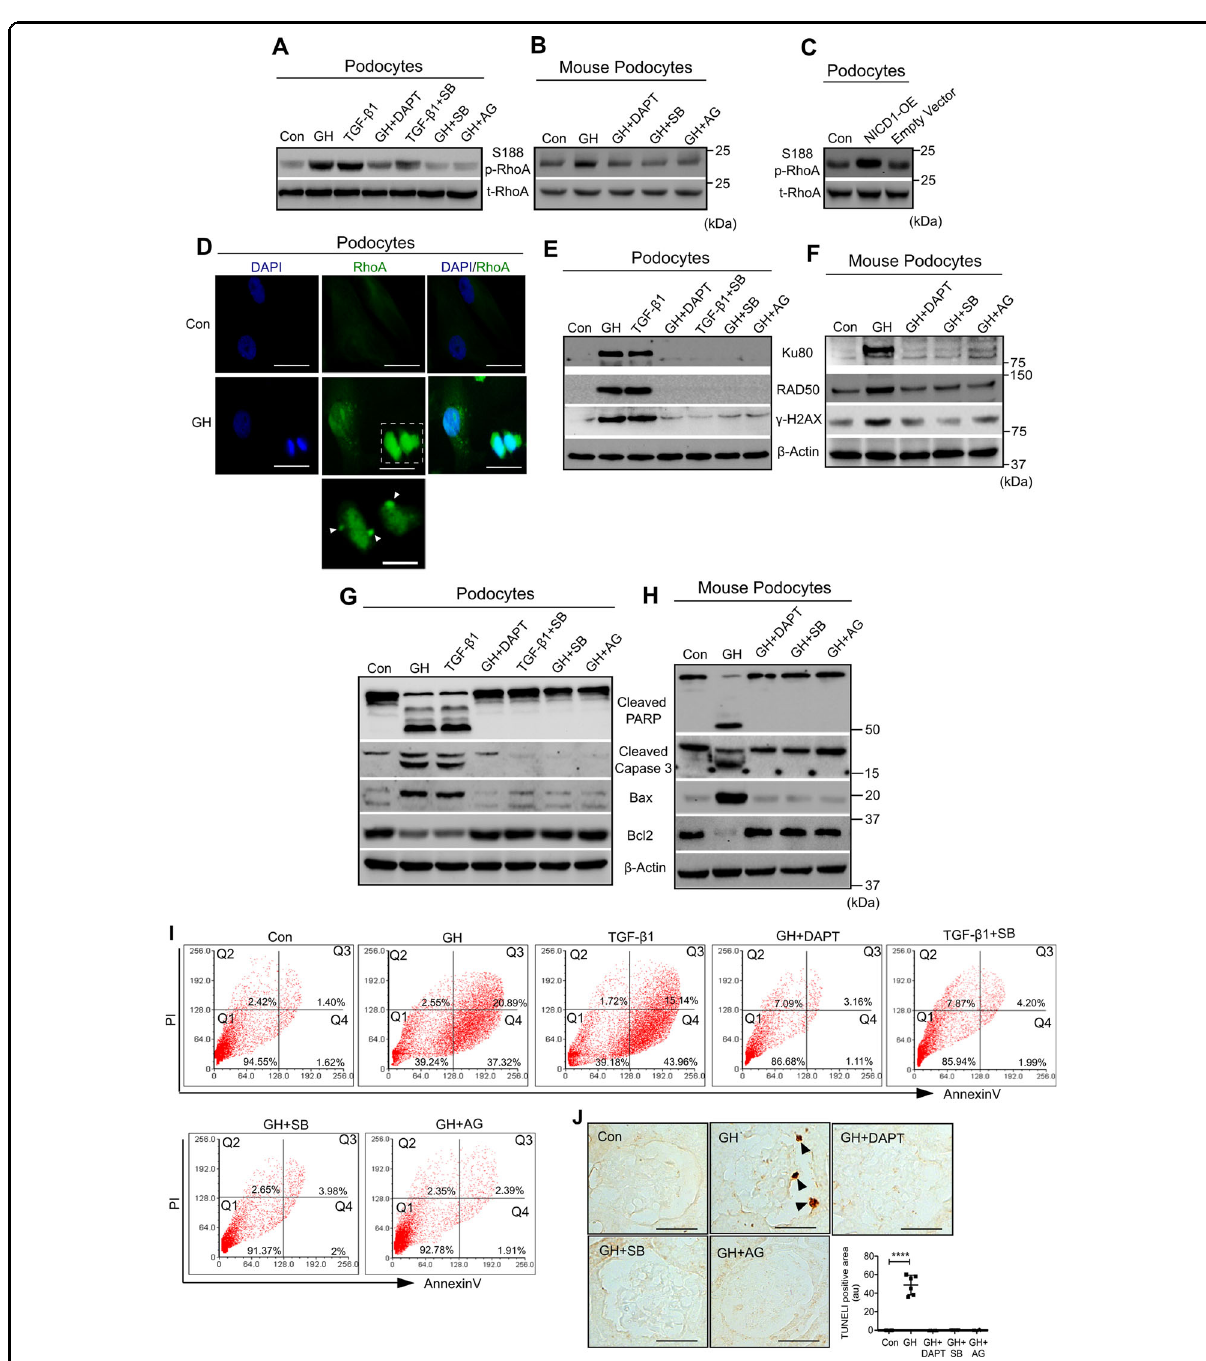
Fig. 4 GH-induced TGF- β leads to podocyte DNA damage and apoptosis. A , B Immunoblotting analysis in human podocytes (treated for 48 h) and from mouse podocytes ( n = 3). C Immunoblotting analysis in human podocytes ectopically expressing NICD1 (NICD1-OE). ( n = 3). D Immuno fl uorescence for the RhoA (green color) and counterstained with DAPI (blue color) in human podocytes treated with GH for 48 h. Magni fi cation ×630. Scale bar = 20 μ m. ( n = 3). White arrowhead indicates the delocalization of RhoA from midbody. E – H Immunoblotting analysis in human podocytes ( E , G ) and mouse podocytes ( F , H ). ( n = 3). I Human podocytes stained with FITC-Annexin V and PI and analyzed by fl ow cytometry. ( n = 4). The values of the representative histograms indicate the percentage of podocytes in the lower left quadrant (live cells), lower right quadrant (early apoptosis), upper right quadrant (late apoptosis), and upper left quadrant (necrotic cells). ( n = 3). J Representative TUNEL (terminal deoxynucleotidyl transferase dUTP nick-end labeling) staining by DAB in mice glomerular sections. Quanti fi cation of TUNEL-postive glomeruli (right panel), where each dot represents the average value of ten glomeruli from each mouse. Magni fi cation ×630, Scale bar = 20 μ m. ( n = 3). **** p < 0.0001 by one-way ANOVA post hoc Dunnett test. β -Actin served as an internal control.